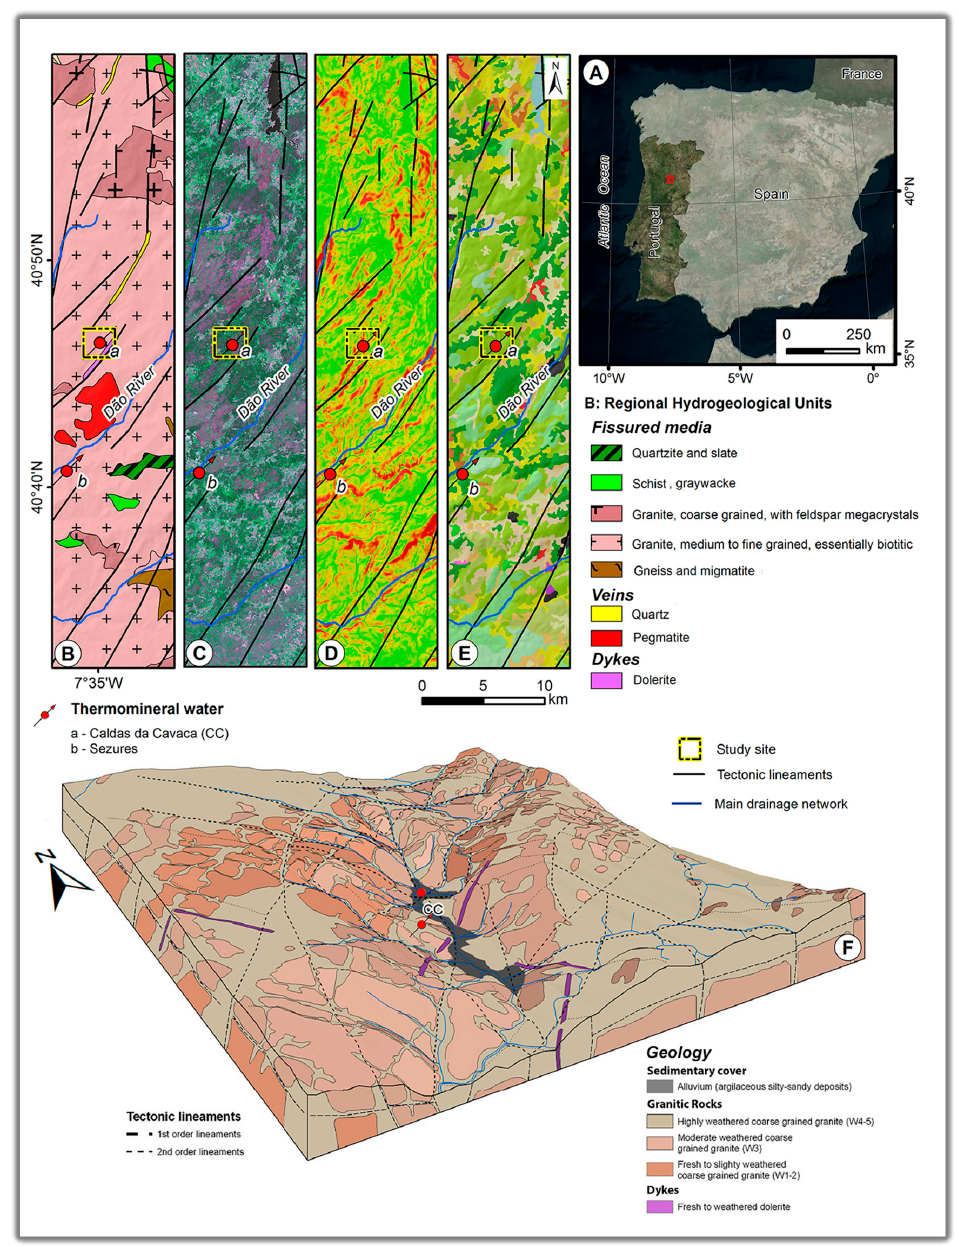
Figure 1. Regional framework of the study area (Caldas da Cavaca hydromineral system, Aguiar da Beira), based on [25,39–41]: ( A ) Regional location of the study site (Central Portugal); ( B ) shaded relief and regional hydrogeology; ( C ) Satellite image and tectonic lineaments; ( D ) Slope; ( E ) Land cover; ( F ) Block diagram illustrating the basic geological framework of the study site.